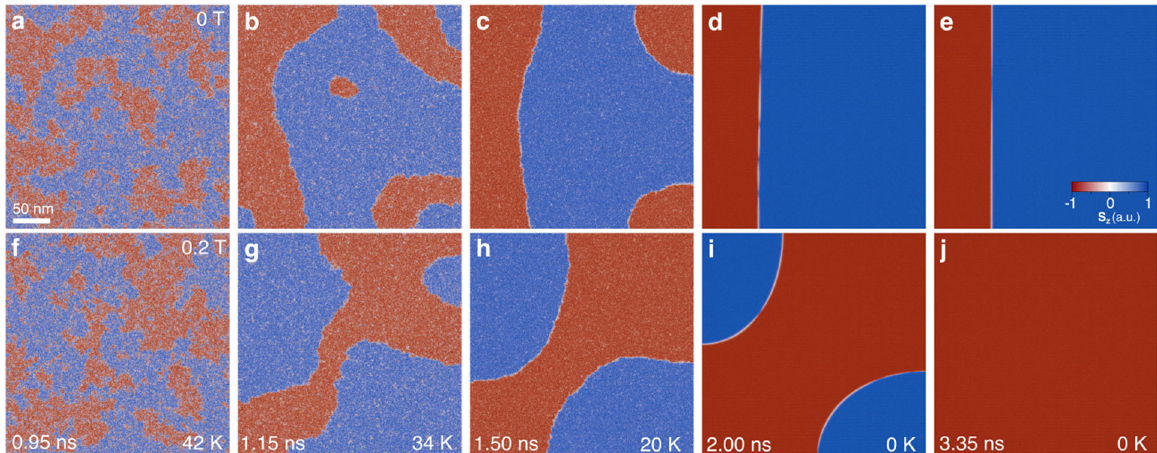
Fig. 1 Magnetic domain evolution of a 2D antiferromagnet. Snapshots of the dynamic spin con fi guration of monolayer MnPS 3 during fi eld- cooling at different temperatures (K), time steps (ns) and different magnetic fi elds: a – e 0 T and f – j 0.2 T. The out-of-plane component of the magnetization S z is used to follow the evolution in a 0.3 μ m × 0.3 μ m square fl ake. Labels on temperatures and time are the same for both magnitudes of the fi eld at the same column. Color scale in e shows the variation of S z . To provide a better visualization of the domains we inverted the color scheme for the two sublattices. That is, spin up (spin down) corresponds to red (blue) for one of the sublattices, and blue (red) for the other. This convention results in a single color for a given domain. See Supplementary Note 8 for further